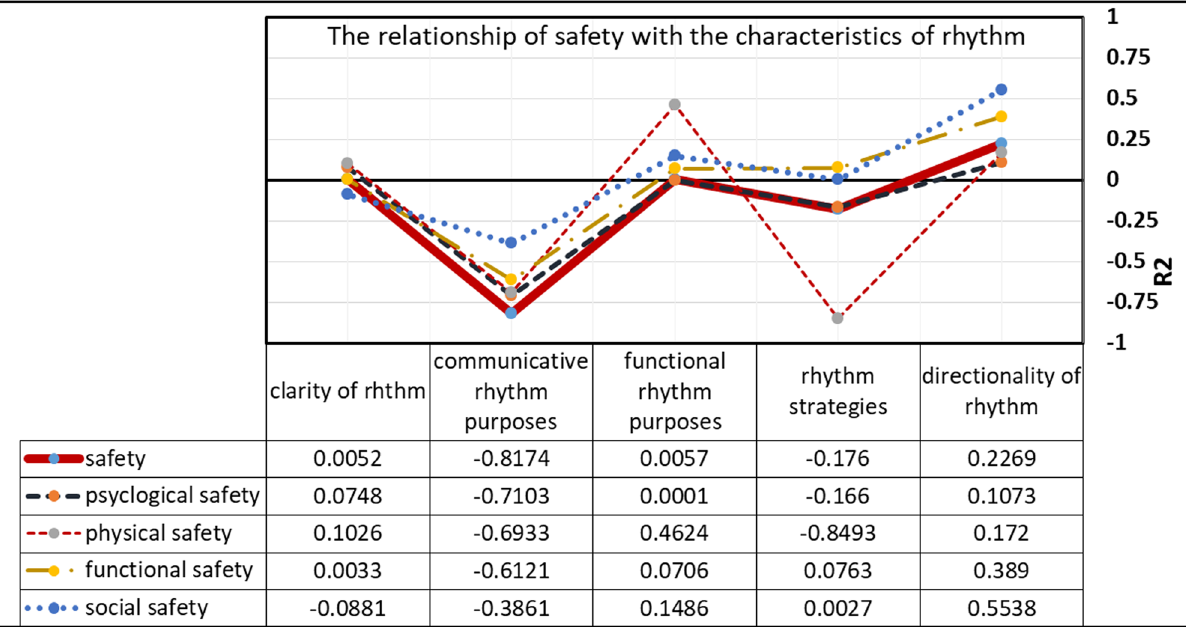
Figure 4: Shows the Pearson correlation coe ffi cient between the research variables.